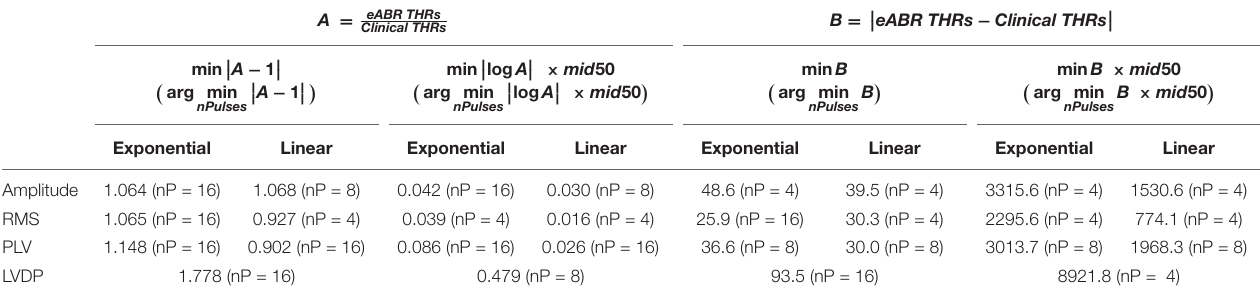
TABLE 3 | Conditions with the closest electrically-evoked auditory brainstem response thresholds (eABR THRs) to clinical THRs for different features and fitting functions (FFs). For each of relations A and B , two expressions were defined, one without considering the between-subject variability ( min (cid:12) (cid:12) A − 1 (cid:12) (cid:12) and min B , respectively) and the other with considering it ( min | log A | × mid 50 and min B × mid 50 , respectively). The variable mid 50 represents the mid 50th percentile (75th percentile–25th percentile). Conditions (argument) in which the minima of expressions occurred are presented in parenthesis. nP , number of pulses. A = eABRTHRs Clinical